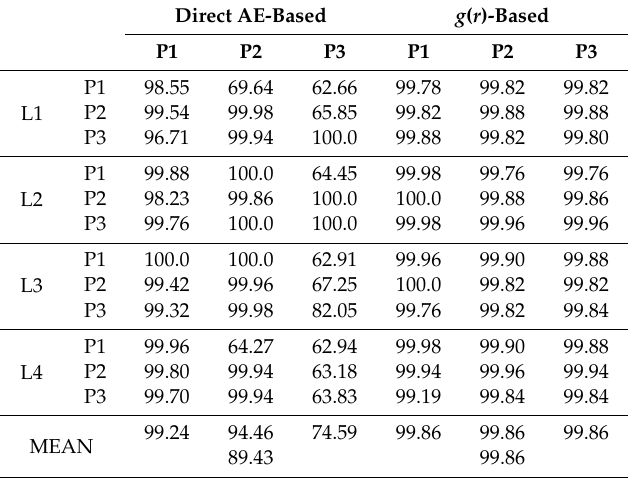
Table 7. Accuracy (%) of classifiers trained with leak L1.